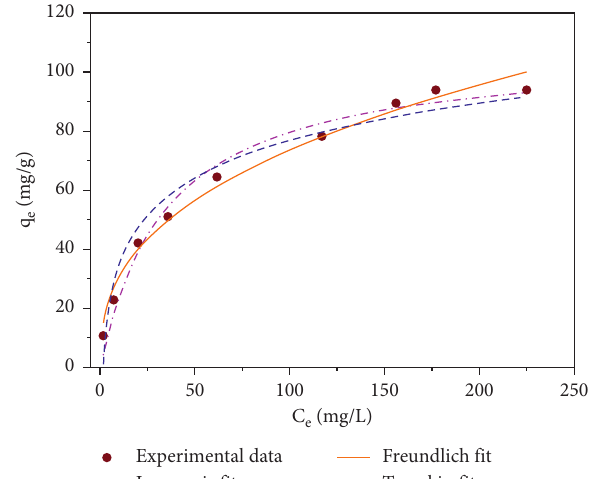
2 O 4 200 at the contact time of 150min, the absorbent dose of